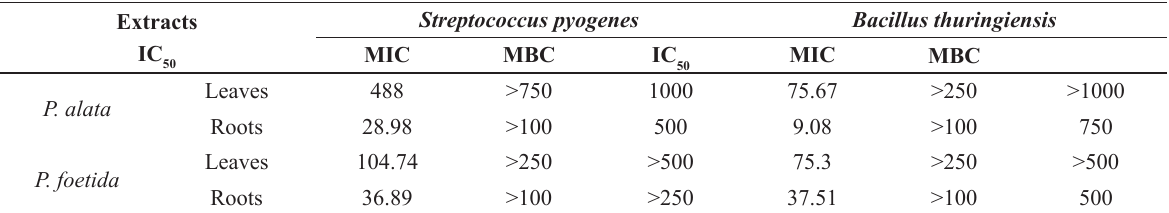
), minimum inhibitory concentration (MIC) and minimum Inhibitory concentration of 50 % of the population (IC 50 bactericidal concentration (MBC) values (µg.mL -1 ) of crude extracts of leaves and roots excised from in vitro -grown plants of P. alata and P. foetida